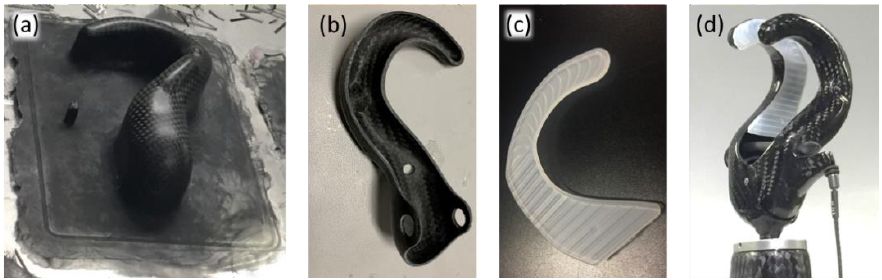
Figure 7. ( a ) Raw carbon fiber part, ( b ) carbon fiber trimmed, ( c ) silicone rubber, and ( d ) final prototype.